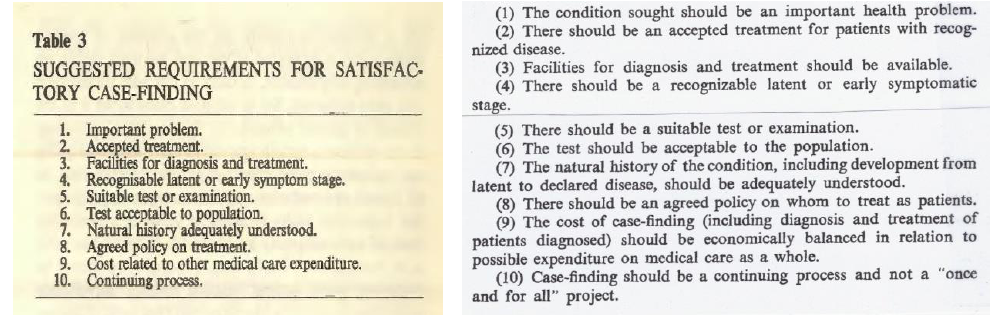
Figure 11. Left, requirements for screening presented by Max to the Oxford meeting in 1965. Right,